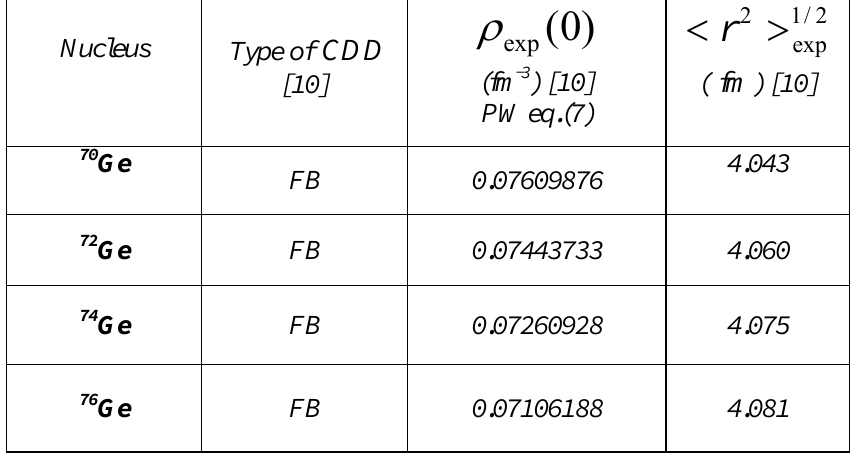
Table 1: The value of various parameters employed to CDD.